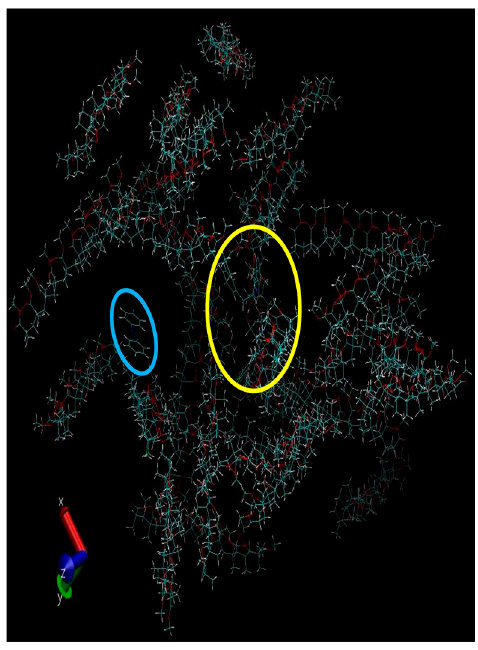
Figure 7. Molecular modeling of 2+AZ+PMMA . 2 : yellow circle; AZ : blue circle.